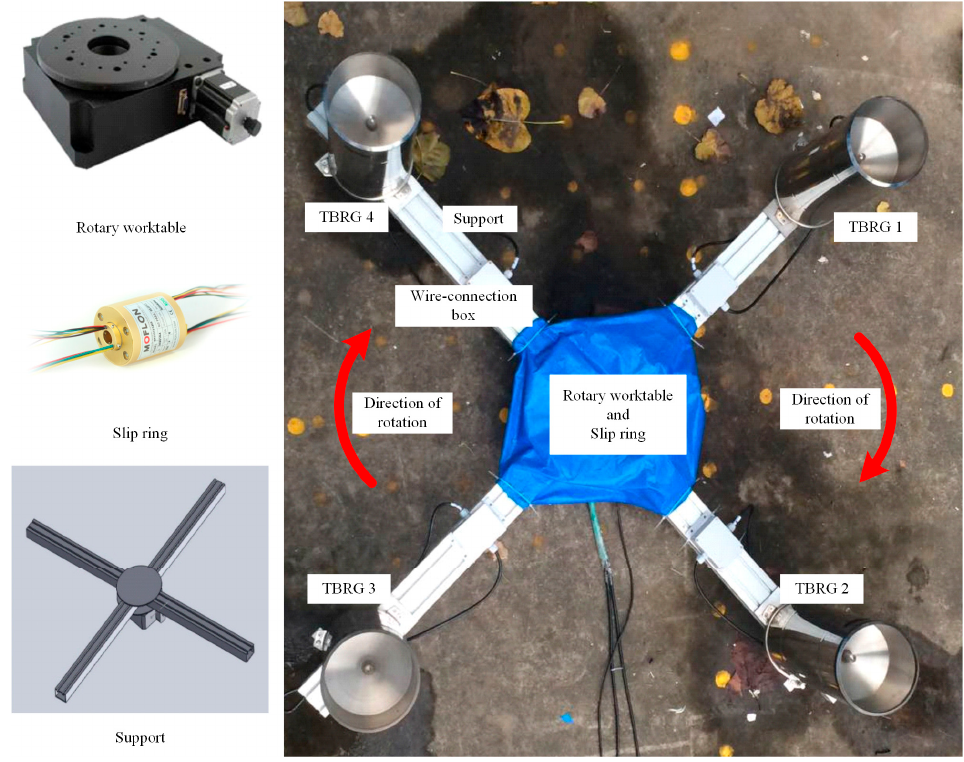
Figure 2. Rotary platform and its main components; the arrows in the figure indicate the direction of rotation.